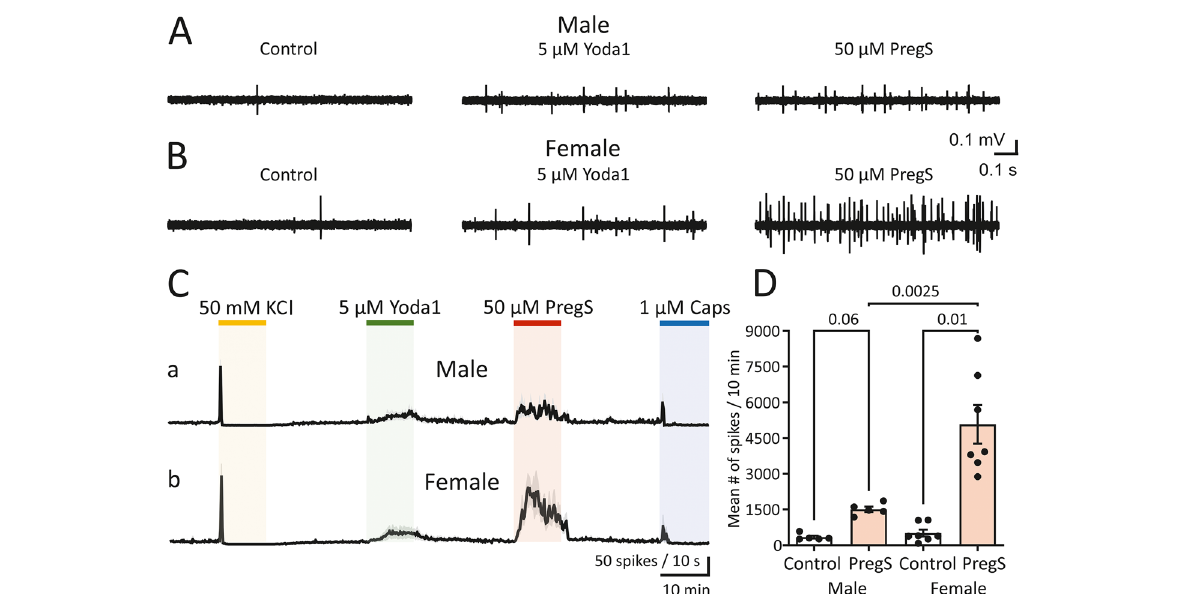
Fig. 1 Activation of trigeminal nerve terminals by PregS in male and female mouse meninges. ( A, B ) Example traces of multi-unit activity (MUA) in the TG nerve innervating meninges in a hemiskull preparation of male ( A ) and female( B ) mice recorded in the control condition (left), after application 5 μ M Yoda1 (middle) and after 50 μ M PregS (right). ( C ) Time course of spike frequency (10-s bin size) induced by application of 50 mM KCl, 5 μ M Yoda1, 50 μ M PregS and 1 μ M capsaicin in males and females (mean ± SEM, n = 5 and n = 7, respectively). Notice the stable recovery of persistence firing during a 20-min washout after each drug application. ( D ) Histograms show the mean number of nociceptive spikes during 10- min recordings before (control) and after application of 50 μ M PregS in males (mean ± SEM, n = 5, p = 0.06, Wilcoxon signed-rank test) and females (mean ± SEM, n = 7, p = 0.01, Wilcoxon signed-rank test). Notice the sex difference in firing when 50 μ M PregS was applied ( p =